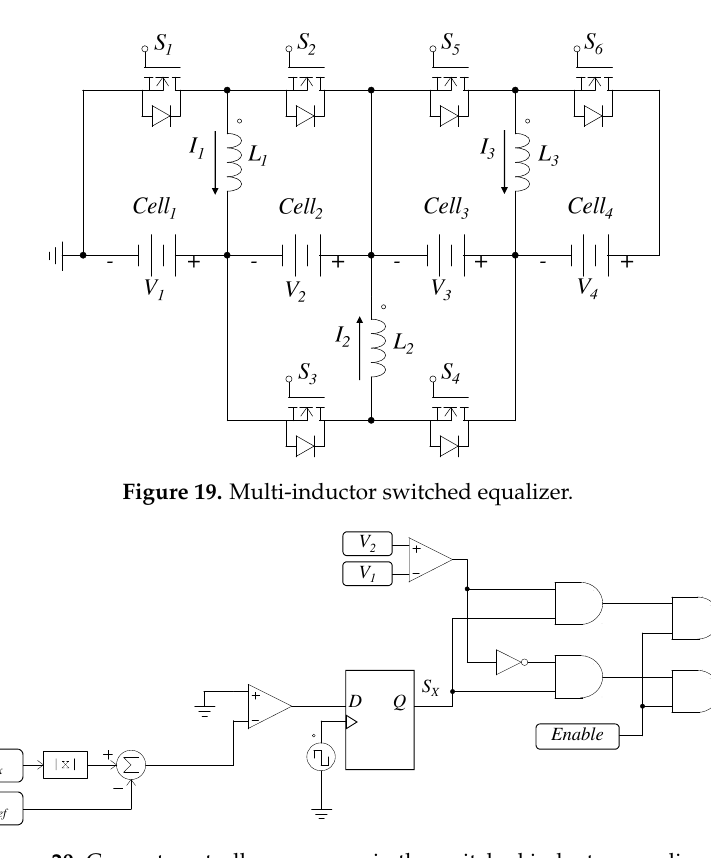
Figure 20. Current controller necessary in the switched inductor